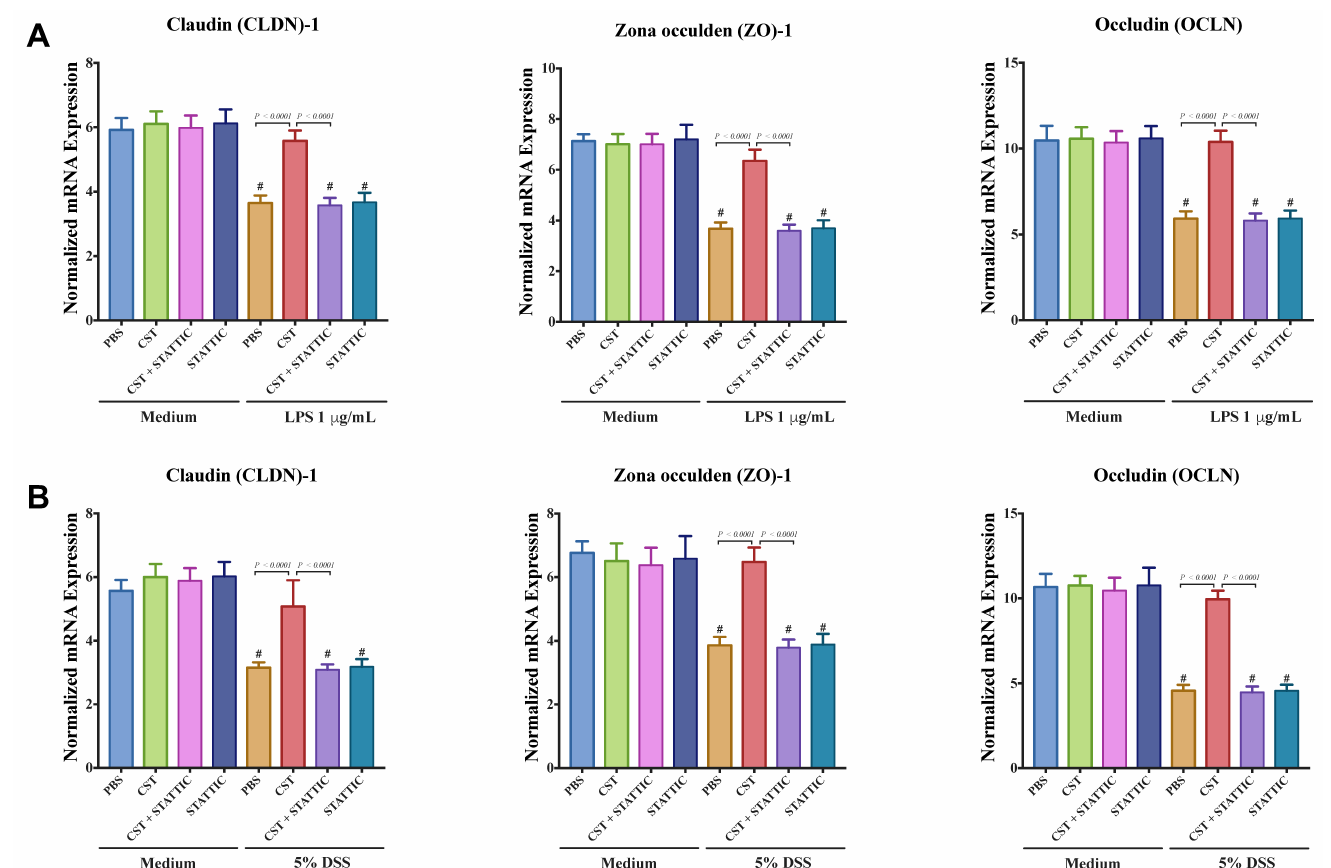
Figure 7. Catestatin (CST) maintains gene expression of TJ proteins in LPS- and DSS-stimulated Caco-2 epithelial cell lines through potentially the STAT3 pathway. Caco-2 cells were treated with 1 × phosphate buffer saline (PBS) or CST (100 ng/mL) in medium for 24 h then challenged with LPS (1 µ g/mL) or 5% DSS for an additional 24 h in the presence or absence of STAT3 inhibitor (10 − 5 M, STATTIC; Sigma, Mississauga, ON, Canada). ( A , B ) mRNA levels expression of TJ proteins (Claudin ( CLDN1 ), zonula occludens-1 ( ZO1 ), and occludin ( OCLN ) in LPS- and DSS-stimulated epithelial cells. One-way ANOVA was used to analyze the data followed by multiple comparison tests. Data represent mean ± SEM ( n = 6–9). # Compared to control groups. Each experiment was repeated at least three